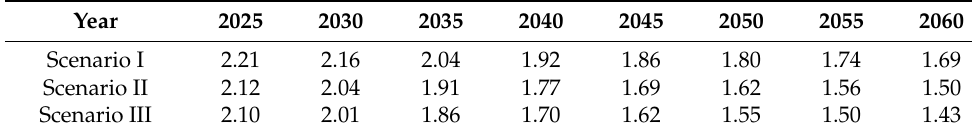
Table 8. Carbon emission factors under different scenario. Table 8. C arbon emission factors under different scenario.